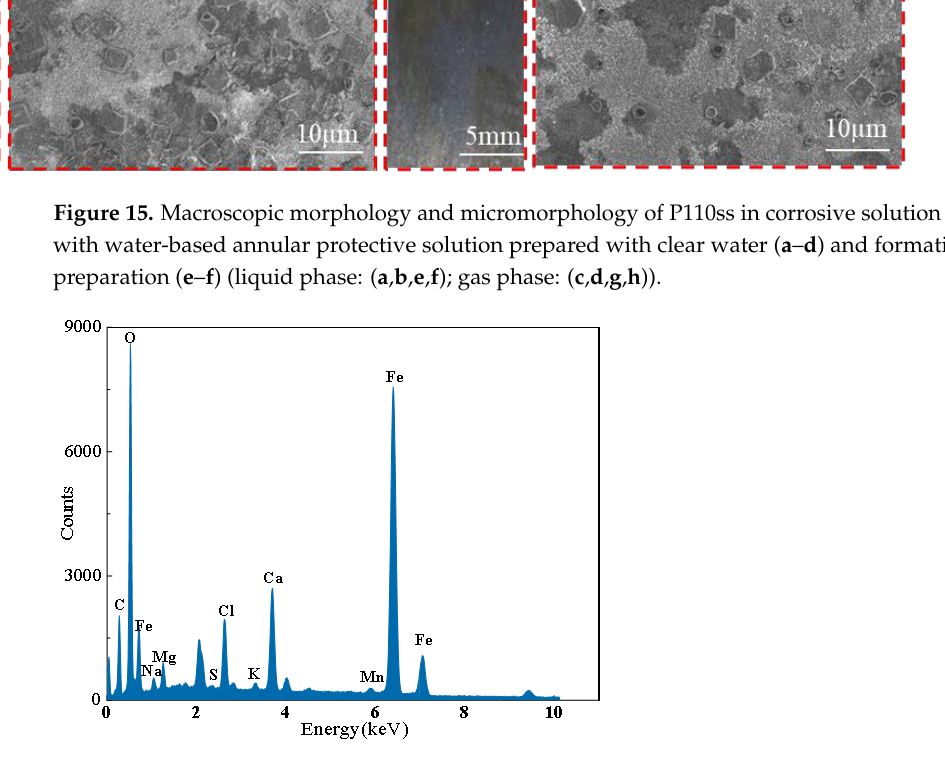
Figure 16. EDS results of corrosion products of P110ss steel in formation water-based annular protective fluid.